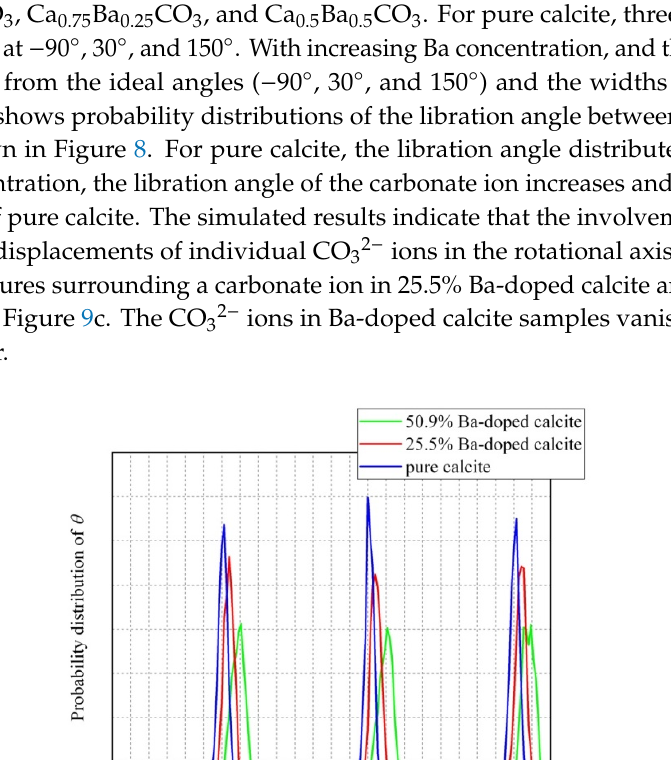
Figure 7. Average probability distributions of rotation angle ( θ ) between the a -axis and the C–O bonds for CaCO 3 , Ca 0.5 Ba 0.5 CO 3 , and Ca 0.5 Ba 0.5 CO 3 at 300 K.